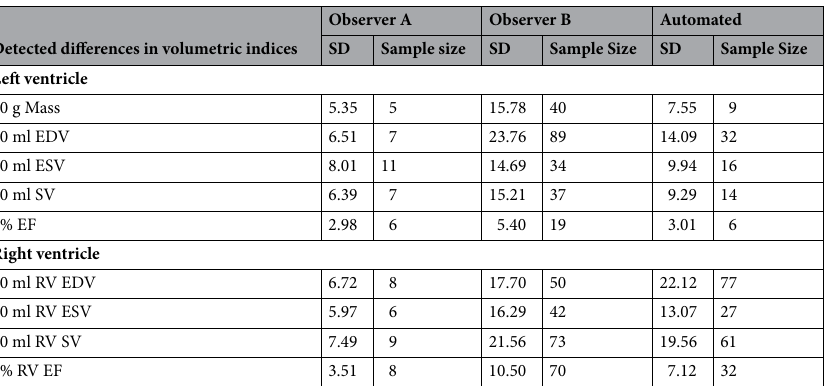
Table 3. Sample size calculation. Sample size calculation for repeated measurements of left and right ventricular volumes for the detection of changes amounting to 10 g mass, 10 ml volumes and 5% EF respectively. EDV end-diastolic volume, ESV end-systolic volume, SV stroke volume, EF ejection fraction, SD standard